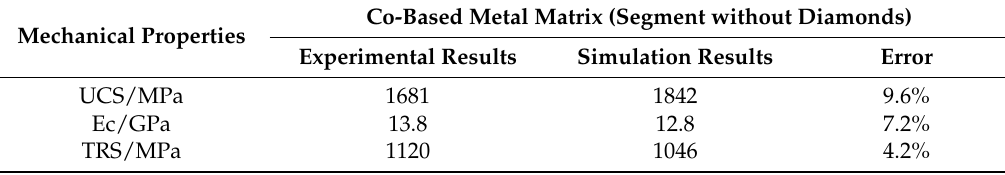
Table 1. Values of UCS, Ec, and TRS of metal matrix obtained by experiment and DEM simulation. Co-Based Metal Matrix (Segment without Diamonds) Mechanical Properties